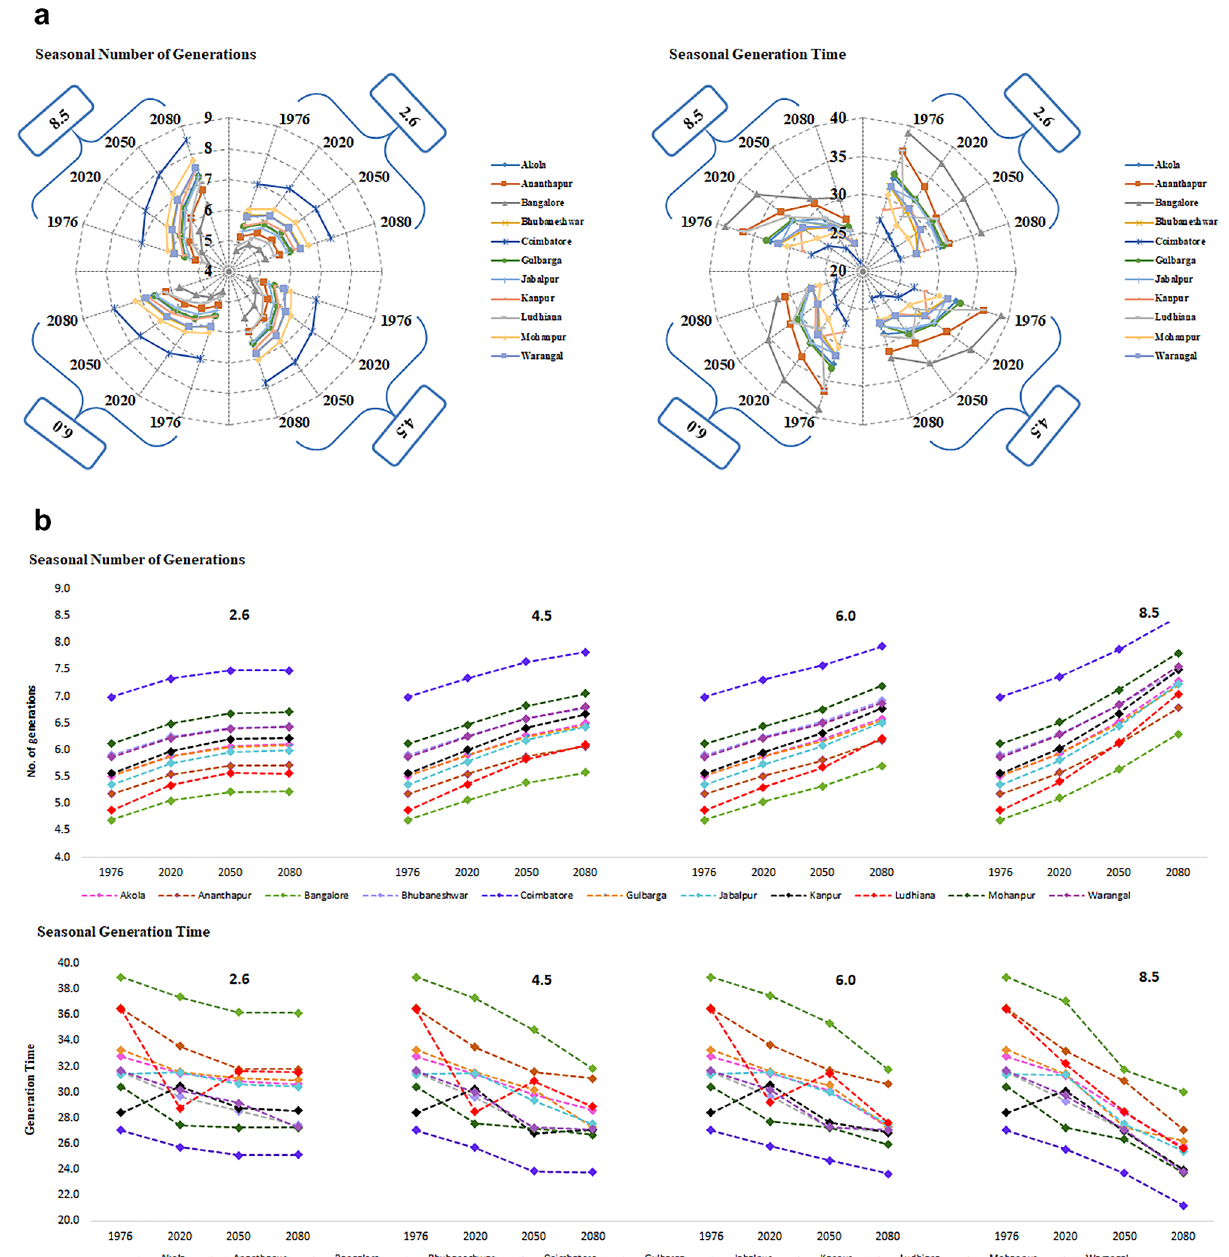
Figure 4. ( a ) Variation in no. of gen. and gen. time of H. armigera in crop season during 3 CCPs over baseline at 11 pigeonpea growing locations of India (RADAR). ( b ) Variation in no. of gen. and gen. time of H. armigera in crop season during 3 CCPs over baseline at 11 pigeonpea growing locations of India